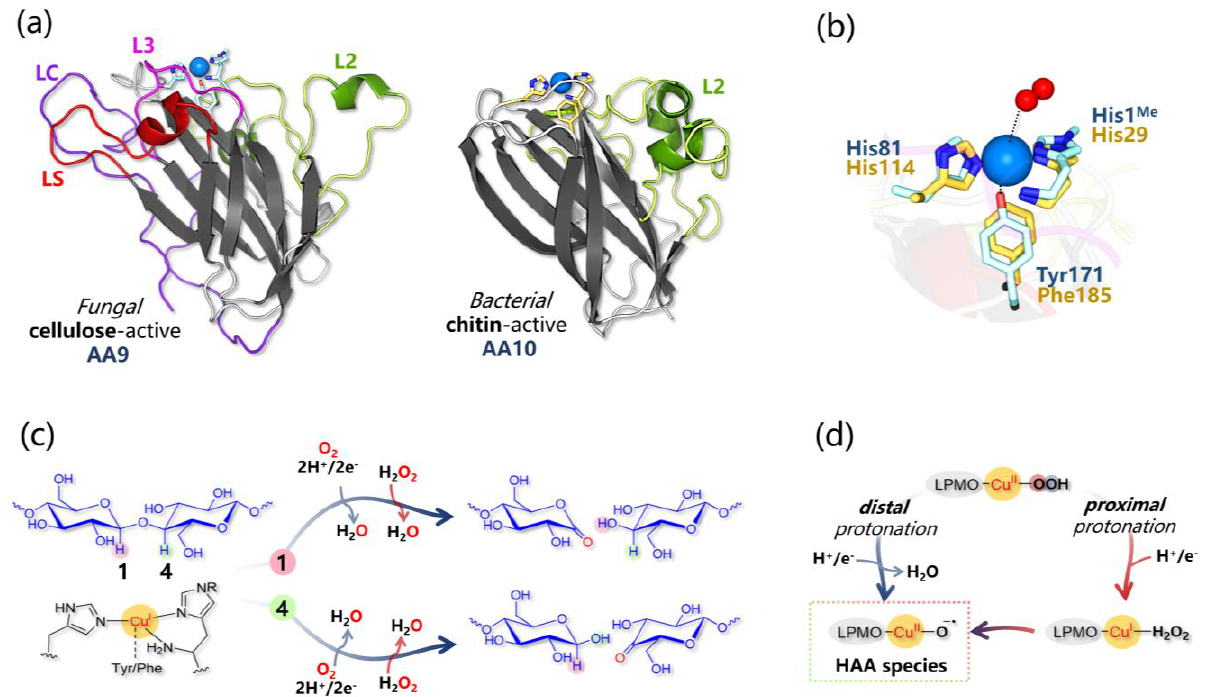
Figure 3. ( a ) Three-dimensional structure of a fungal AA9 (cellulose-active) and a bacterial AA10 (chitin-active) LPMO (PDB: 4EIS and 4ALC, respectively). The β-sandwich fold is in grey, binding- surface loops are highlighted in different colors, and copper is represented as a light blue sphere. ( b ) Structural detail on the active site of LPMOs depicted in panel ( a ) (AA9 in light blue and AA10 in yellow). The dioxygen molecule is only found in PDB 4EIS and water molecules are omitted. ( c ) General mechanism of LPMOs for oxidation at 1 or/and 4 positions in the presence of O 2 or H 2 O 2 as a co-substrate. ( d ) Calculated pathways for the formation of the Cu-oxyl species according to distal or proximal protonation of the Cu-OOH − intermediate.